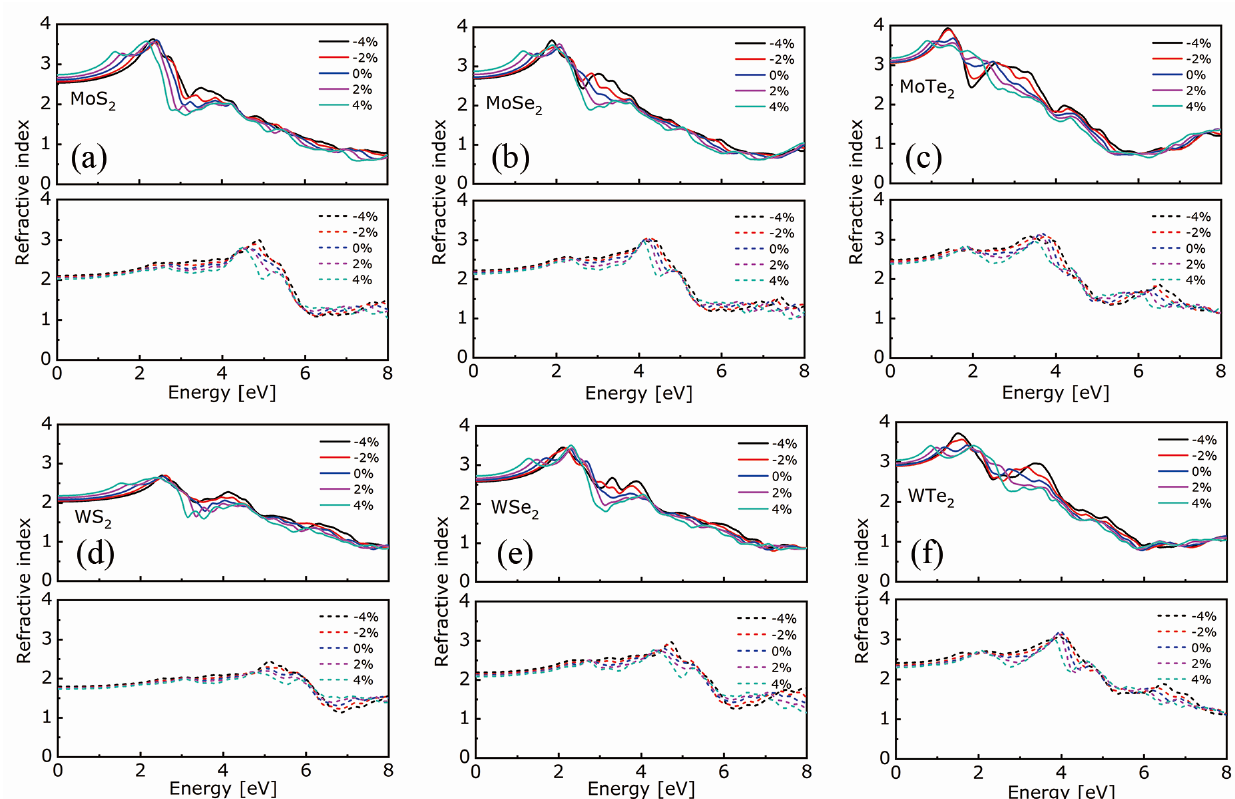
Figure 5. Refractive indexes of ( a ) MoS 2 , ( b ) MoSe 2 , ( c ) MoTe 2 , ( d ) WS 2 , ( e ) WSe 2 , and ( f ) WTe 2 in the xx - (top panel) and zz -direction (bottom panel) as the biaxial strain goes from −4% to +4%.